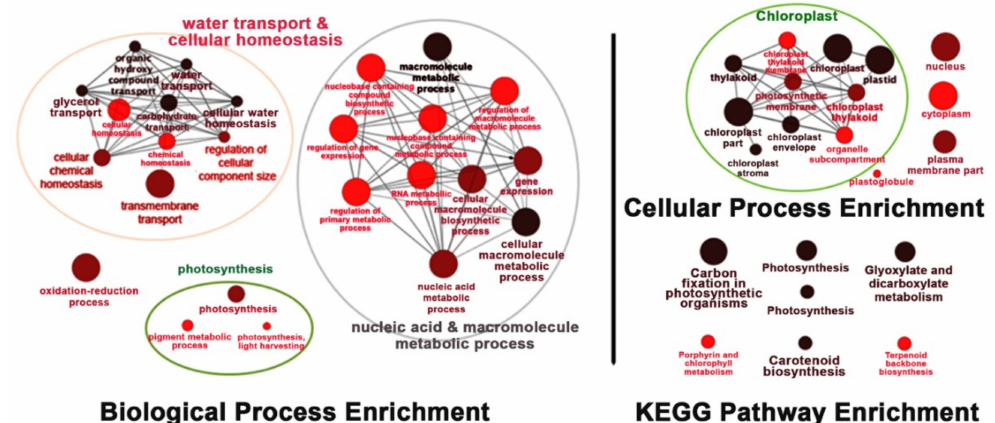
Figure 8. The enrichment for the biological process, cellular process, and Kyoto Encyclopedia of Genes and Genomes (KEGG) pathways of the differentially expressed genes in the flag leaves of transgenic rice overexpressing OsNUC1-S after 3 days of salt stress. The darker colors represent the higher significance and the larger size of node represents the higher number of genes in the group.